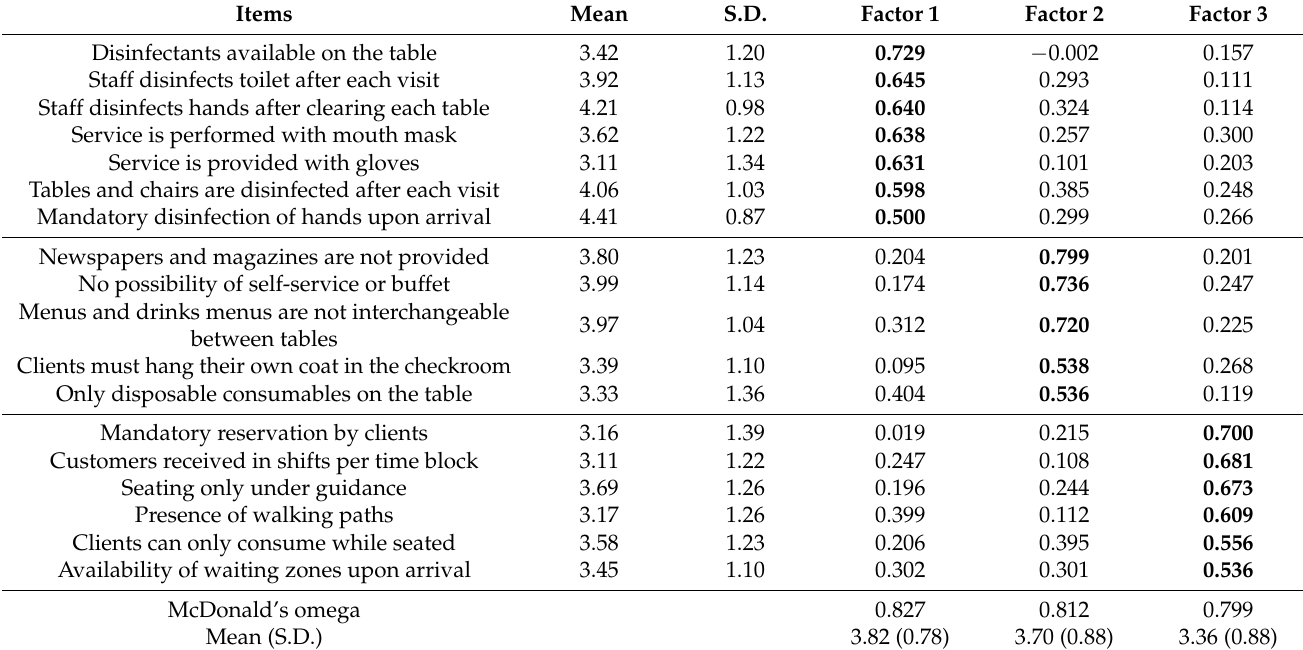
Table 3. Factor loadings from principal component analysis for consumers’ attitudes towards ex- pected safety measures (study 1; n =